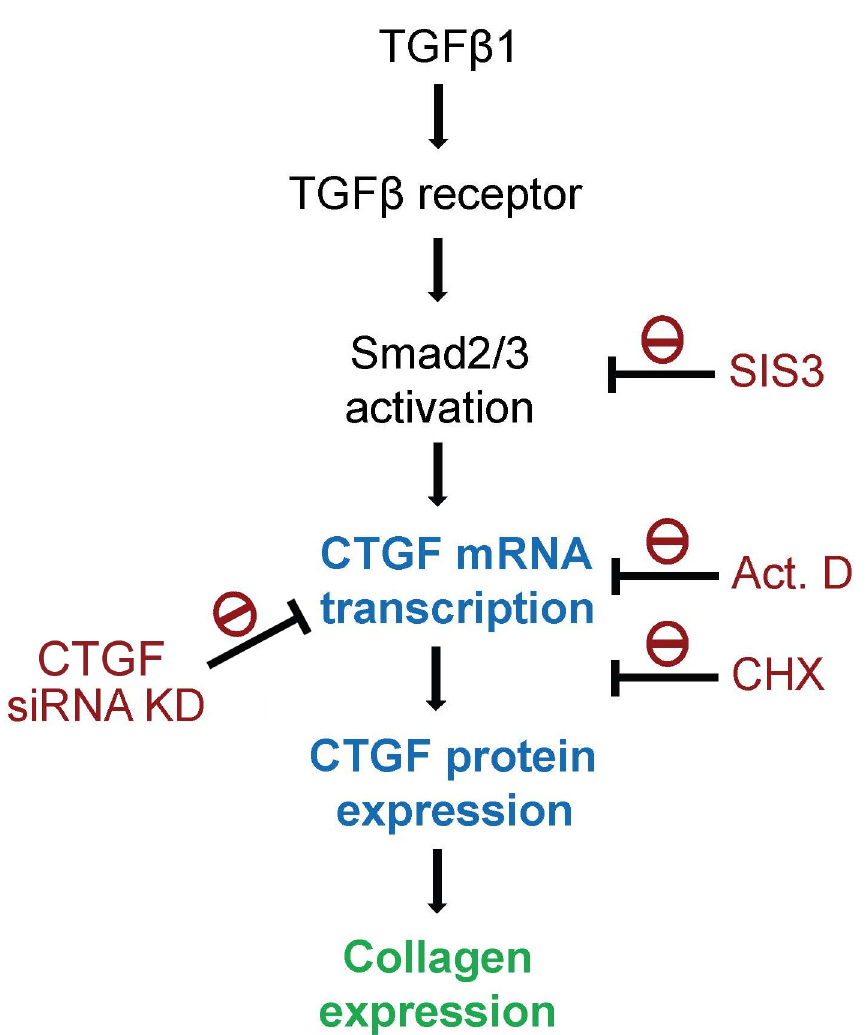
Fig 8. Proposed scheme of TGF β 1 signaling in inducing CTGF and collagen expression in human endometrial stromal cells.